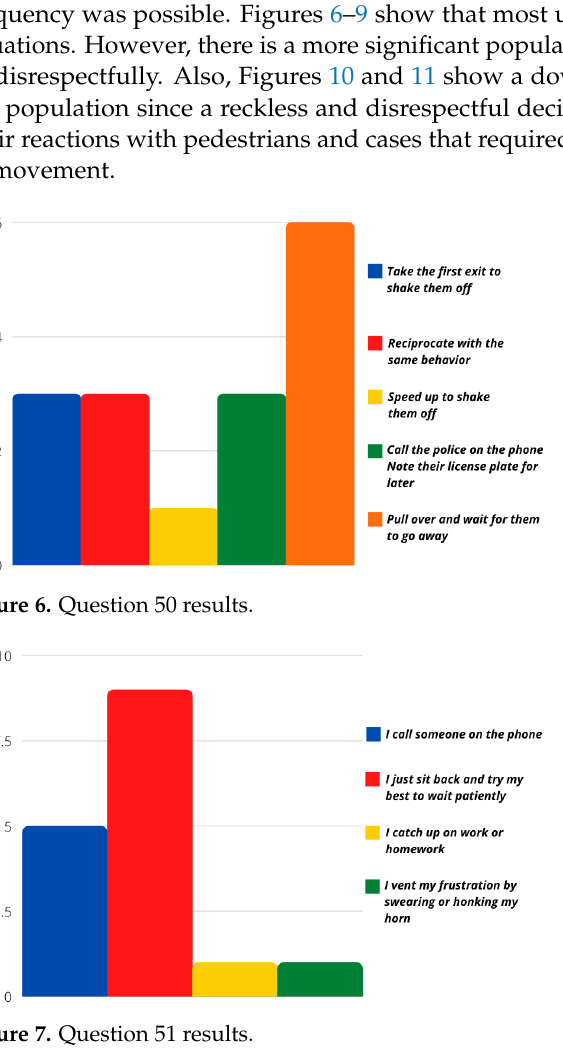
Figure 7. Question 51